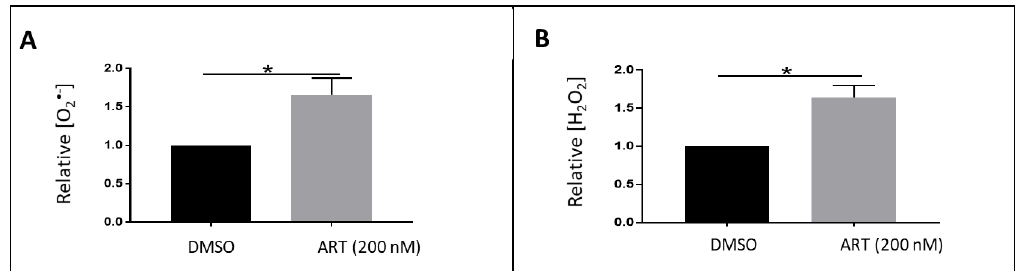
Figure 6. Quantification of superoxide ( A ) and H 2 O 2 ( B ) in parasitized RBCs treated with artemisinin